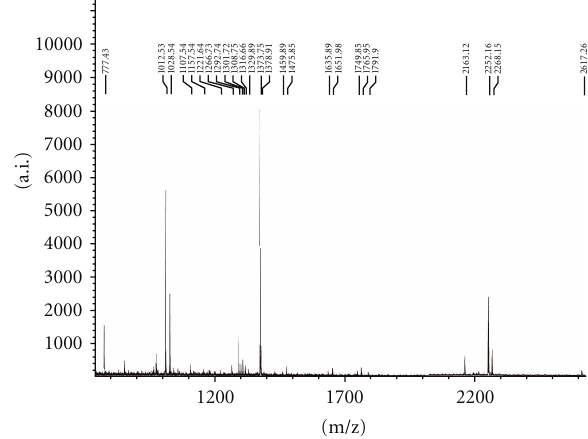
Figure 6: Peptide mass fingerprinting map of protein spot